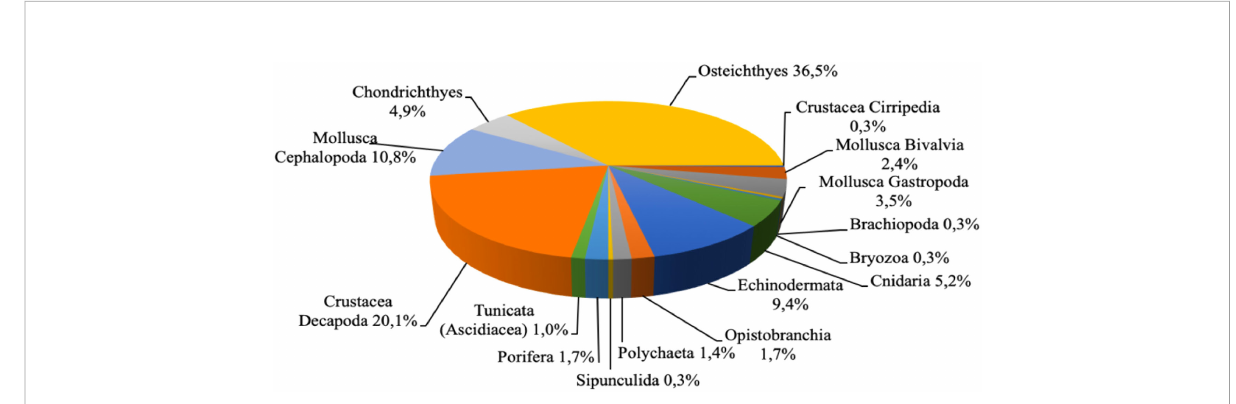
FIGURE 2 Percentage composition of species by taxonomic groups identi fi ed in the deep-sea assemblage of the north-western Ionian Sea from 2012 to